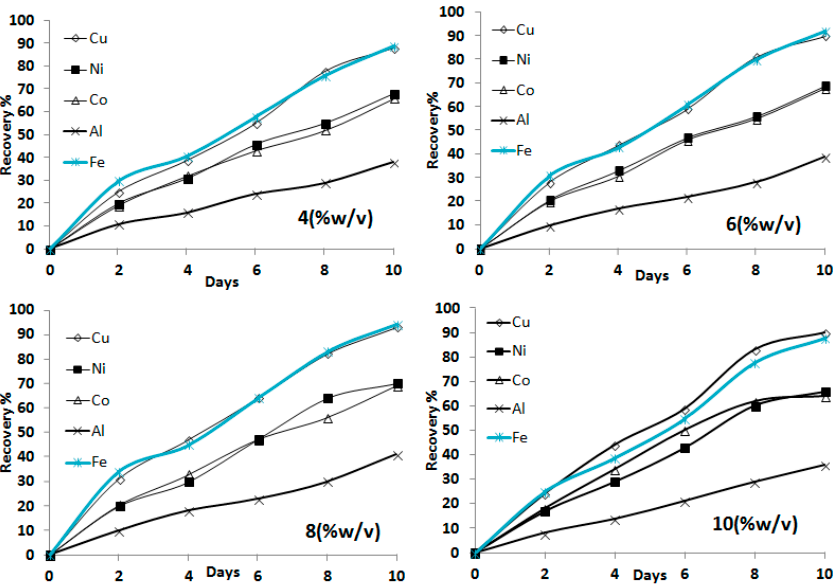
Figure 4. Metal recovery yields in various pH conditions during fungal leaching of PCB at 2% PD, 308 K.